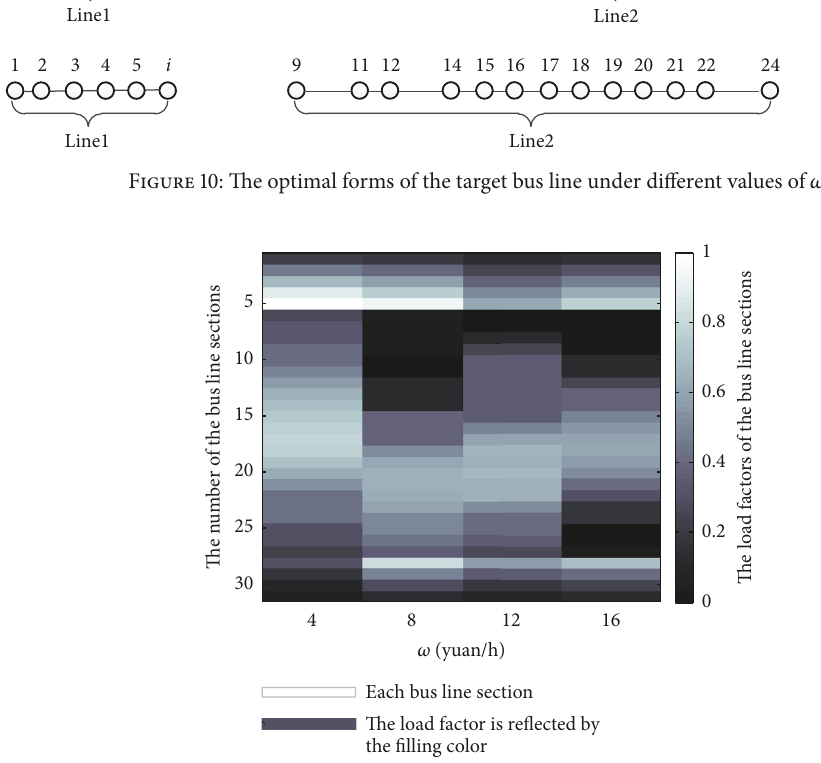
Figure 11: The load factor of bus line under different values of 𝜔